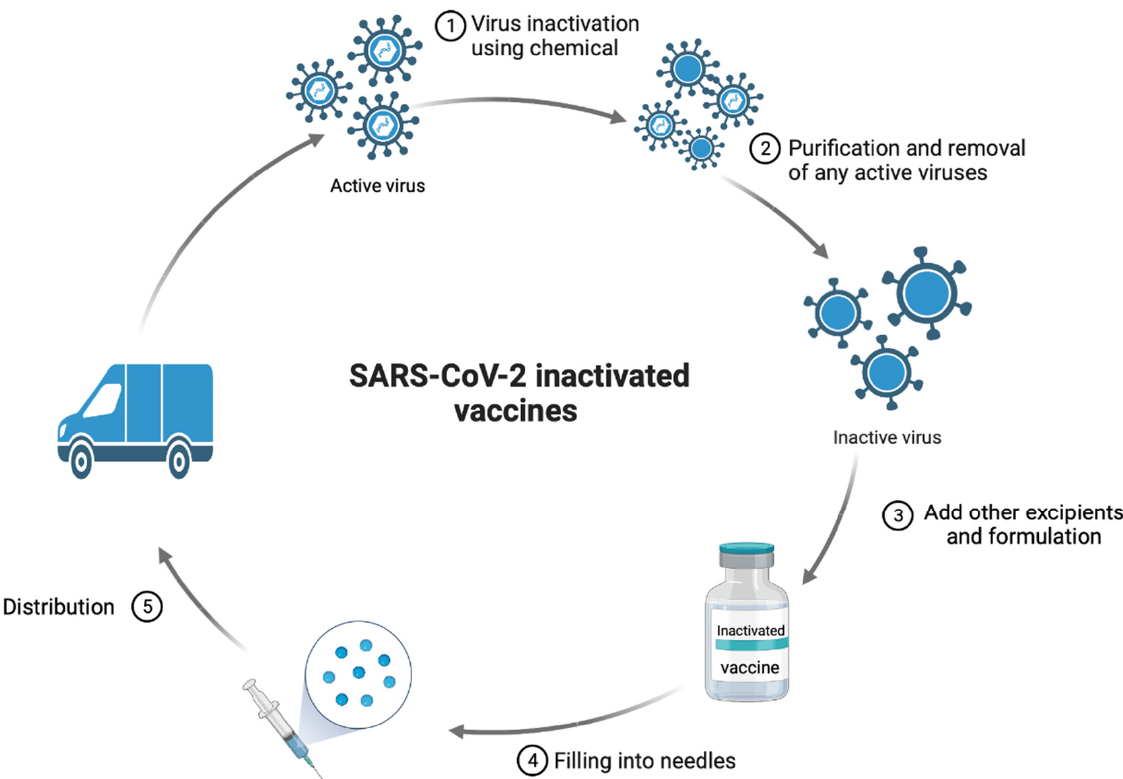
Figure 2. COVID-19 whole virus vaccine development.